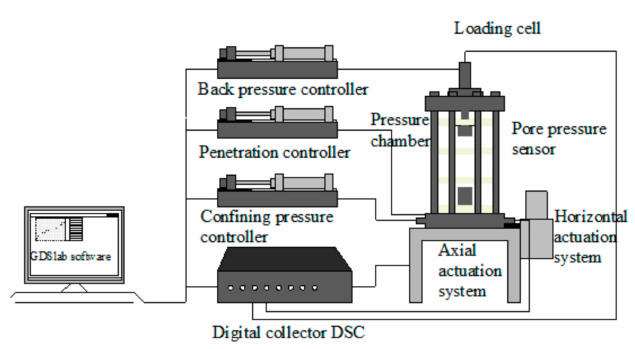
Figure 4. GDS triaxial instrument.